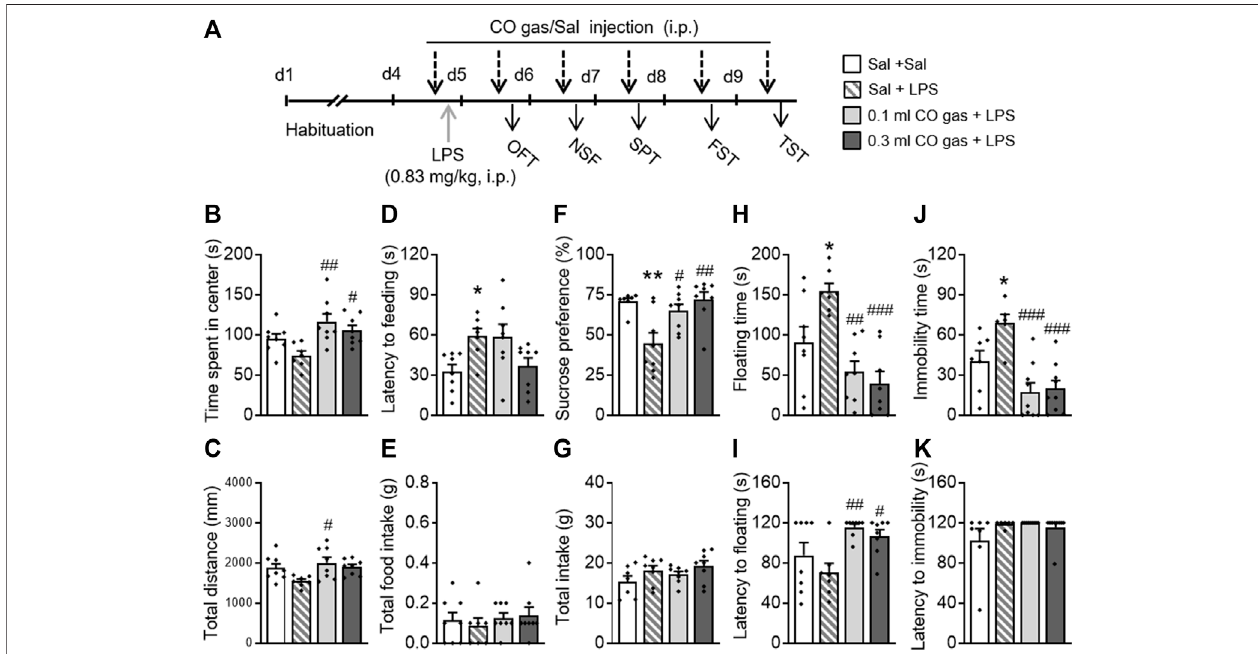
FIGURE 5 | Systemic CO gas administration signi fi cantly blocked LPS-induced depressive and anxiety-like behaviors. (A) LPS (0.83 mg/kg, 0.2 ml/mouse, i.p.) wasadministeredonthelast day ofthe 3-day-adaptation period,while COgas(0.1,0.3 ml, i.p.)wasadministered 30 minbeforeLPSinjection and each behavioral test. CO gas treatment increased time spent in the center (B) and total distance (C) as compared to the LPS injection group in the OFT. In the NSF test, LPS treatment increased feeding latency (D) but not total food intake (E) . CO gas treatment signi fi cantly reversed the depressant-like state induced by LPS, re fl ected by the increased sucrose preference (F) but no change in total water intake (G) in the SPT. Increased fl oating time reversed by CO gas (H) and decreased fl oating latency (I) induced by LPS in the FST. In the TST, CO gas treatment signi fi cantly reversed the increased immobility time (J) induced by LPS but not latency to immobility (K) . The data are expressed as mean ± SEM and were analyzed with separate one-way ANOVAs. * p < 0.05, ** p < 0.001 as compared to the Sal + Sal group; # p < 0.05, ## p < 0.01, ### p < 0.001 as compared to the Sal + LPS group; Sal, saline. LPS, lipopolysaccharide; OFT, open fi eld test; NSF, novelty-suppressed feeding; SPT,